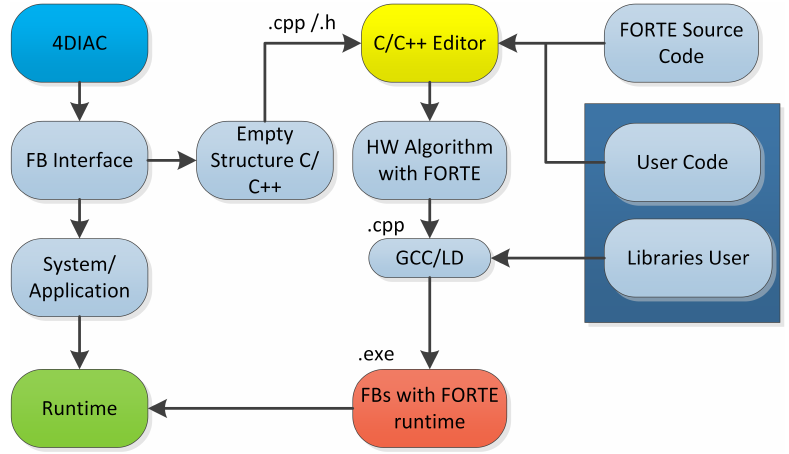
Figure 5. General scenario of software development using 4DIAC and